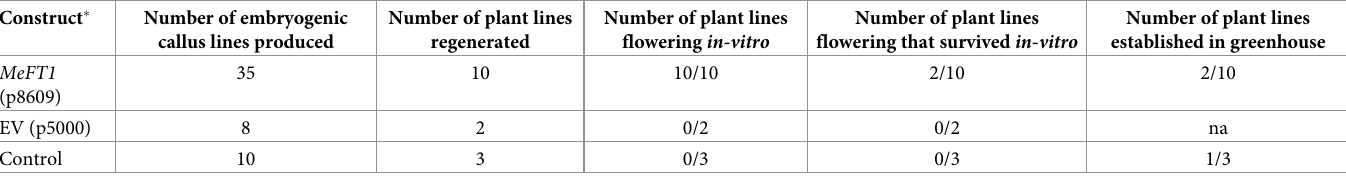
Table 1. Production of transgenic plant lines in cv. 60444 and flowering rates under in-vitro conditions. Number of plant lines Number of plant lines Number of plant lines Number of plant lines Construct � Number of embryogenic callus lines produced regenerated flowering in-vitro flowering that survived in-vitro established in